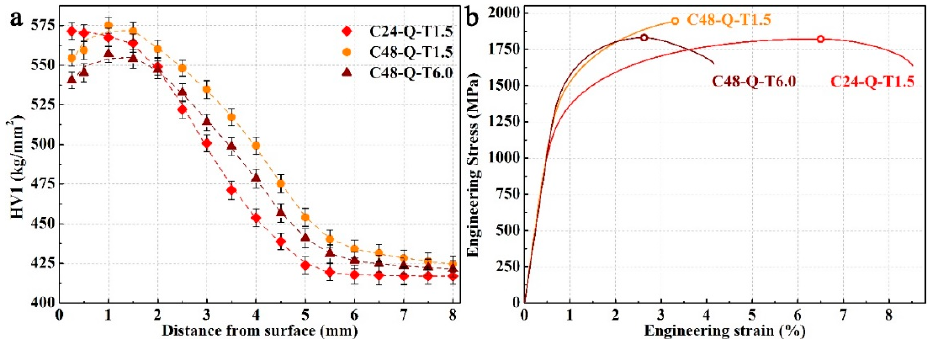
Figure 3. Hardness distribution in the carburized layer of the specimens processed with different carburizing/tempering durations ( a ) and engineering stress–strain curves of the surface layer of the specimens ( b ).